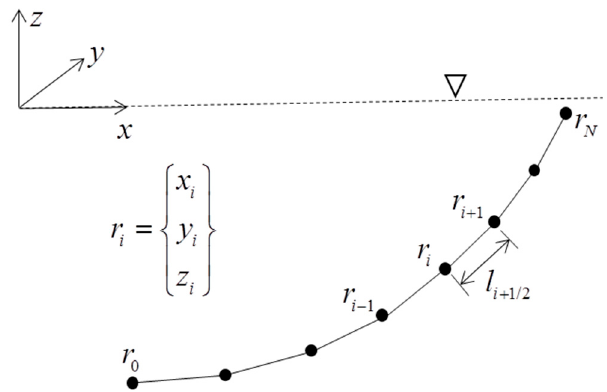
Figure 2. Mooring line discretization and indexing.